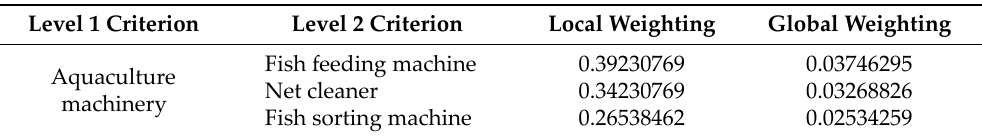
Table 12. Level 2 criteria priority evaluation results for Level 1 ‘aquaculture machinery’ criterion using the modified AHP.